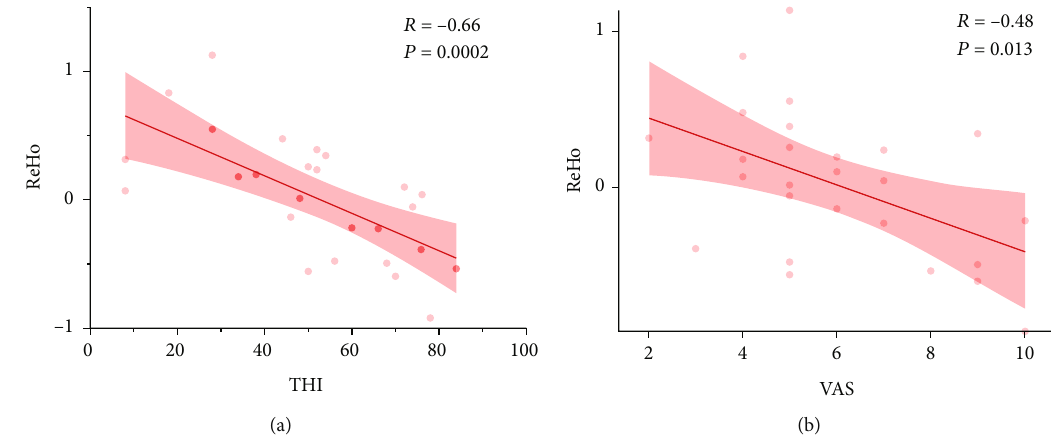
Figure 4: ReHo is signi fi cantly correlated with tinnitus THI and VAS scores. (a) Frontal lobe ReHo values were negatively correlated with THI scores ( R = − 0 : 66 , p = 0 : 002 ). (b) Frontal lobe ReHo values were negatively correlated with VAS scores ( R = − 0 : 48 , p = 0 : 013 ).